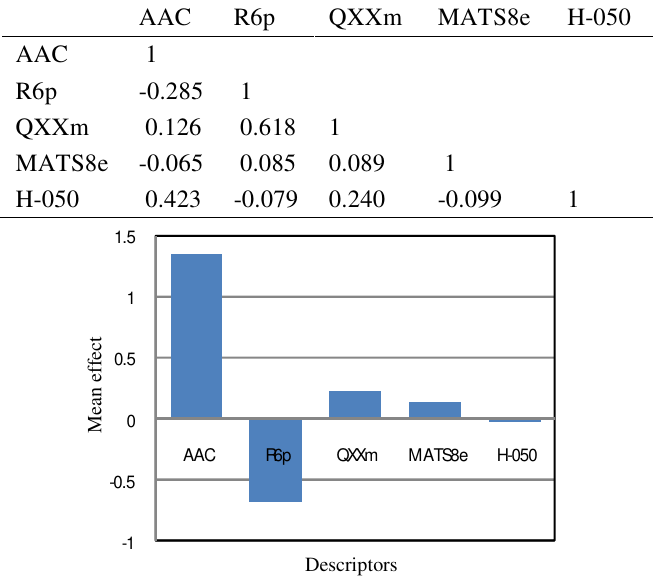
Table 3. Correlation matrix for descriptors applying in this work